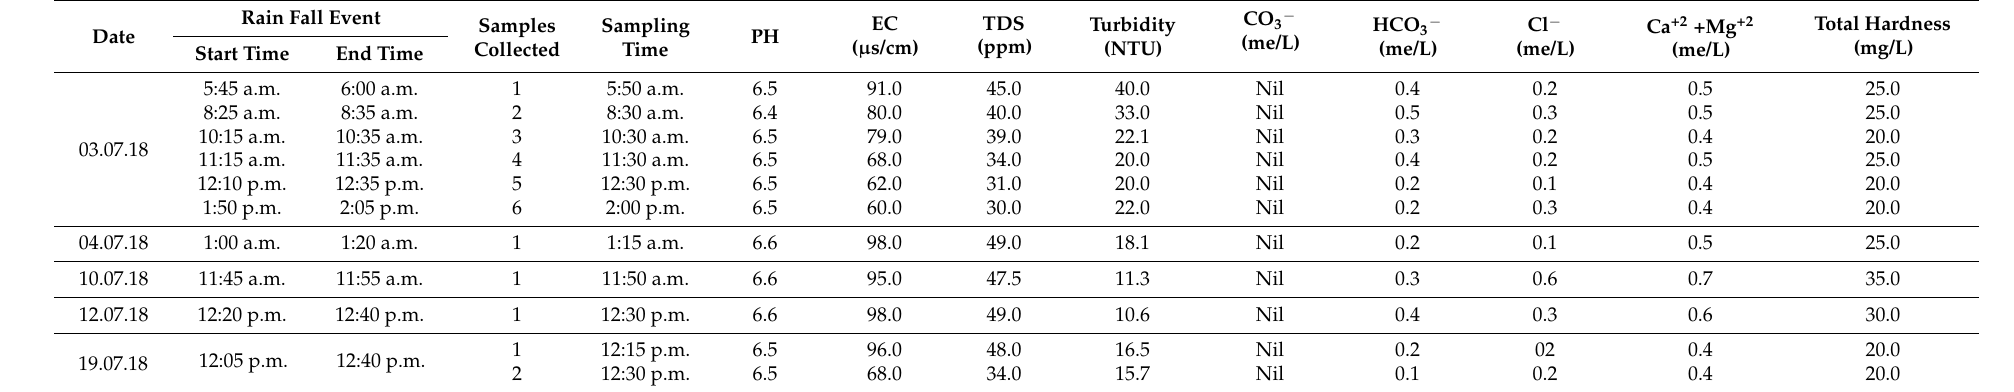
Table A7. Roof run off rain samples collected from Site